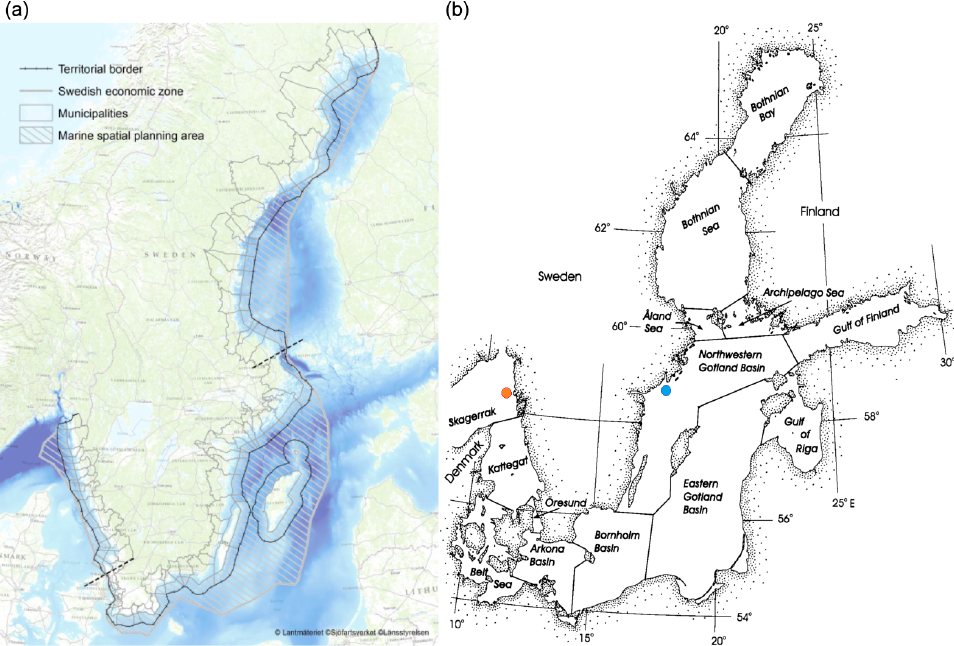
Figure 2. (a) Map of the SEEZ around Sweden in focus for this study. (b) Map of the considered water basins. The same basin terminology is used throughout the article (credits to HELCOM, 2018). The blue marker indicates the station at Landsort, while the orange marker points at the station of